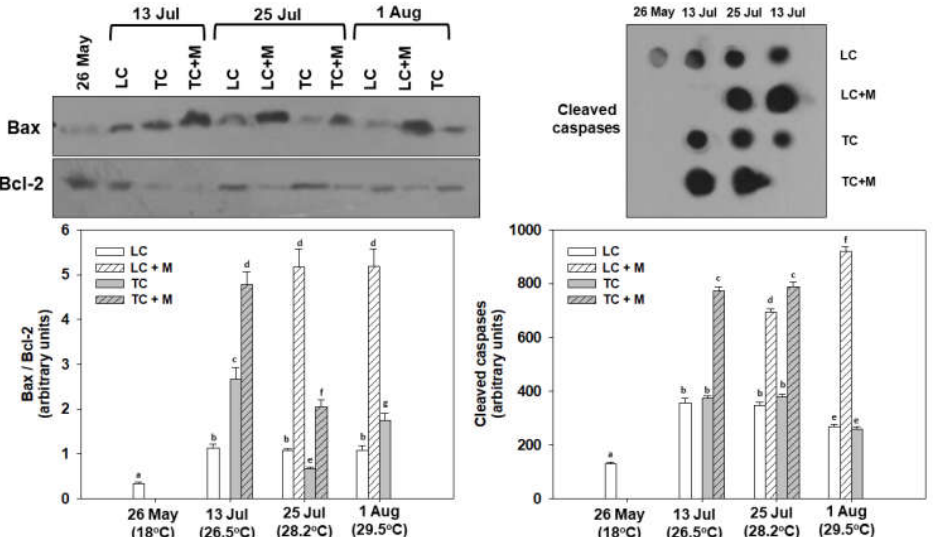
Figure 9. Bax/Bcl-2 ratios and cleaved caspase levels in the mantle of M. galloprovincialis specimens, either infected by Martelia spp. (M) or not. Samples were collected from Thermaikos Gulf during a summer heatwave both from traditional culture-Bouchot (TC) and long-line system (LC). Representative blots and dots are shown. Values represent means ± SD; n = 5 preparations from different animals. Lower case letters indicate statistically significant differences ( p < 0.05) between